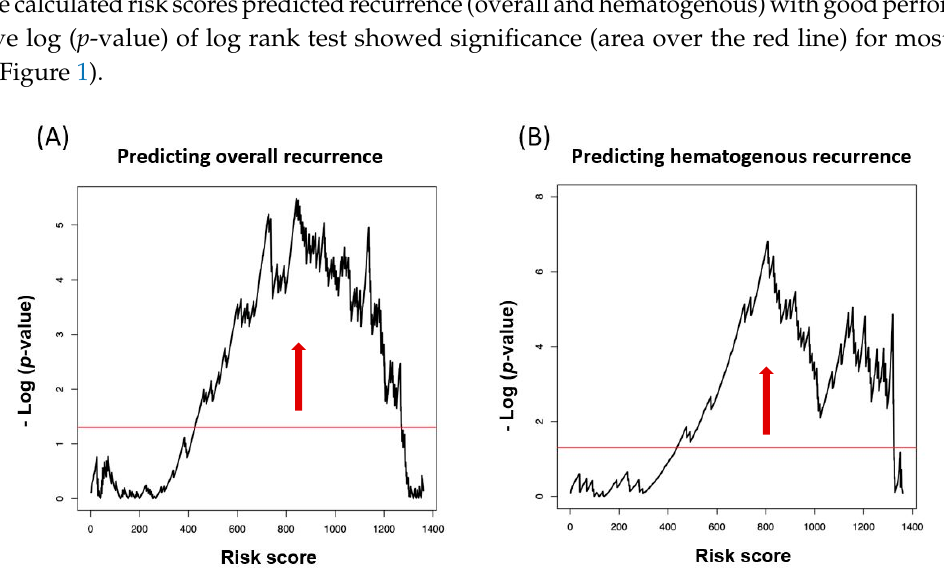
Figure 1. ( A ) Distribution of risk scores calculated by the built models to predict disease-free survival (DFS) and ( B ) hematogenous recurrence. The red horizontal lines represent the negative log of 0.05. The risk scores distributed above the red lines demonstrate statistical significance. The red vertical arrows indicate the risk scores with the smallest p -values in each model. These risk scores were used to dichotomize high-risk-score group vs. low-risk-score group in further analysis described in Section 3.3.